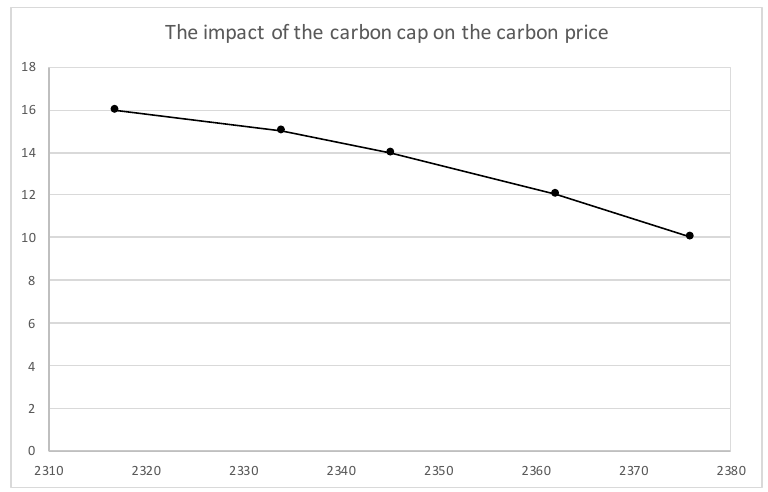
Figure 1. Impact of the carbon cap on the carbon price($)